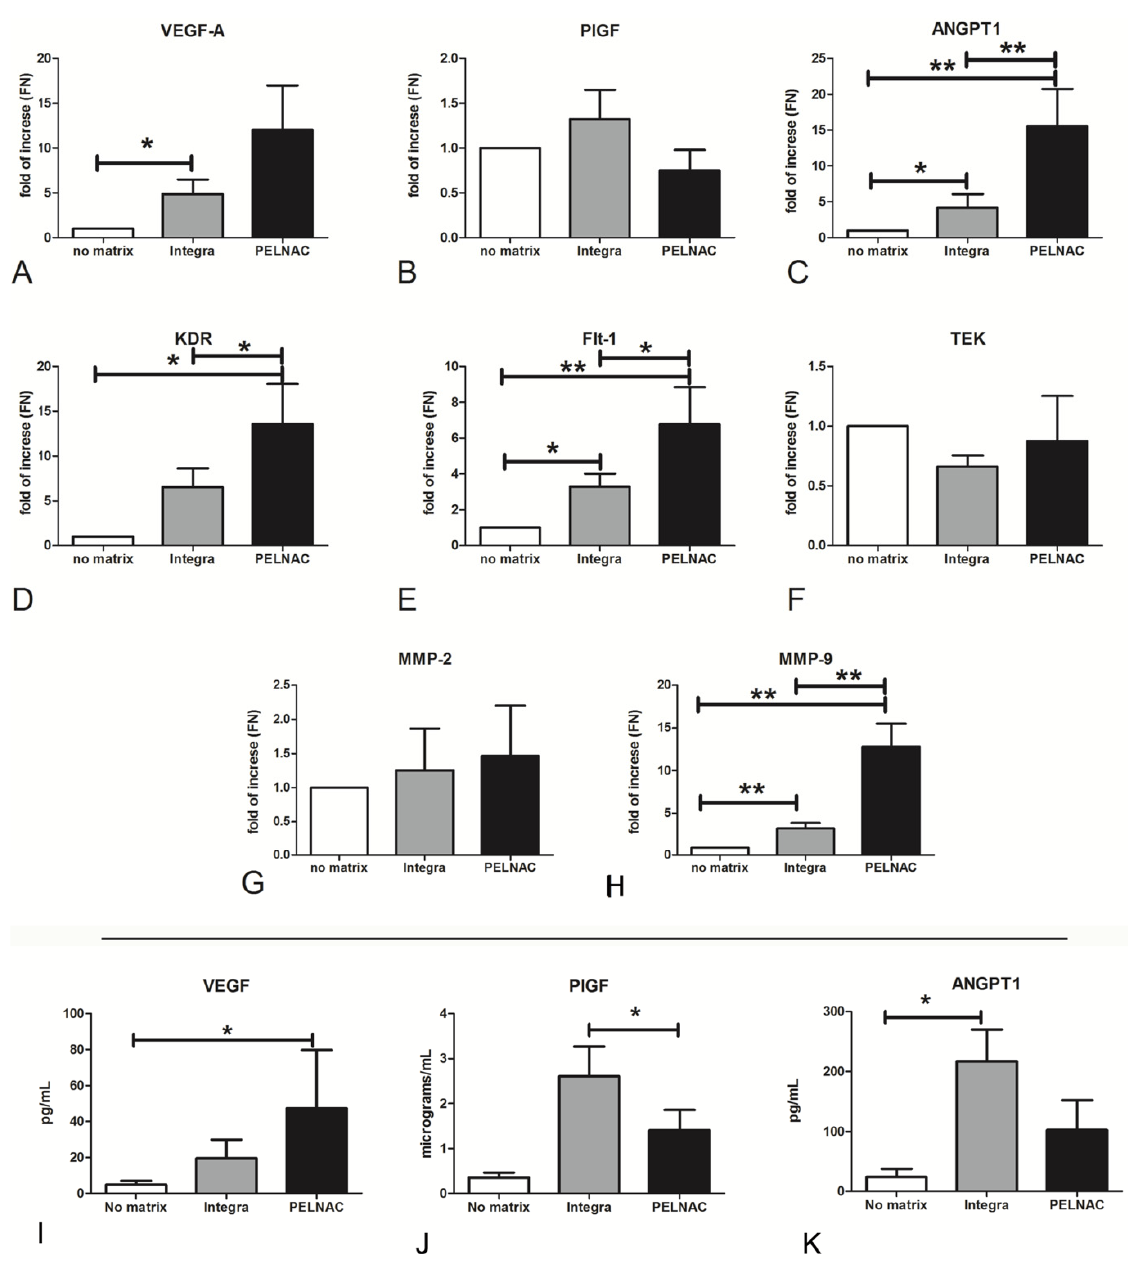
Figure 4. ( A – H ) RT-qPCR of VEGFA, PlGF, ANGPT1, KDR, FLT1, TEK, MMP2 and MMP9 expressed by ADMECs cultured onto different matrices for 36 h. The expression level of the genes is described as fold of increase with respect to the mean of normalized values of 18S, GAPDH and TBP as housekeeping genes. Data are expressed as the mean ± SE of duplicate samples from four separate experiments: * p < 0.05, ** p < 0.01. ( I – K ) Production of VEGF-A, PlGF and ANGPT-1 by ADMECs cultured on matrices. Thirty-six hours after ADMEC, the supernatant was collected and protein concentration was determined by ELISA. Data are presented as the mean ± SE of duplicate samples from three separate experiments.